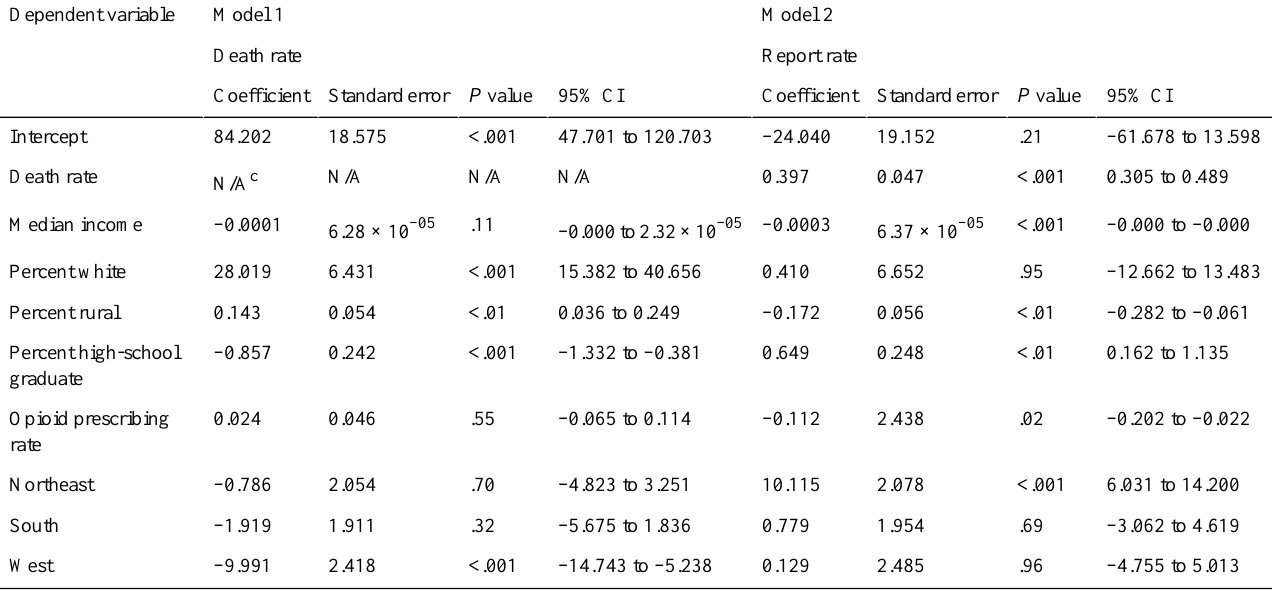
Table 1. Summary of regression results of Models 1 and 2 a,b